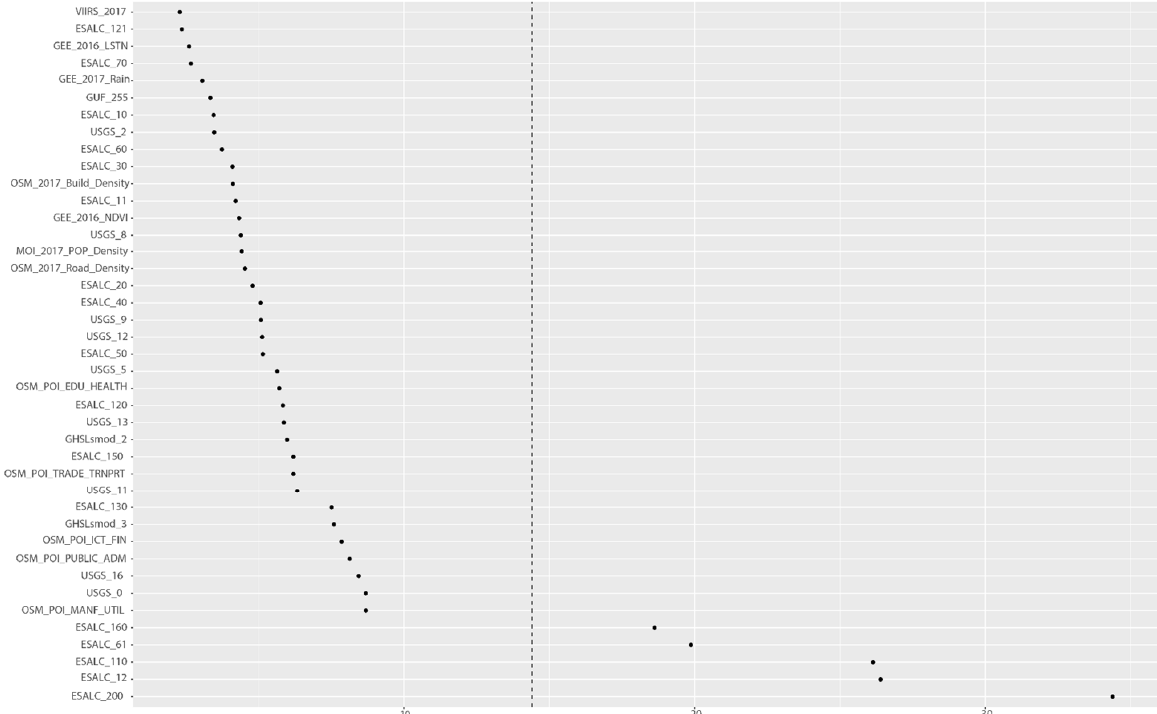
Figure 16. Result of Minimal Depth (MD) analysis on predicting poverty headcount rates of 2015 (based on RF’s outcome). Source: Calculation and graphics generated by authors.